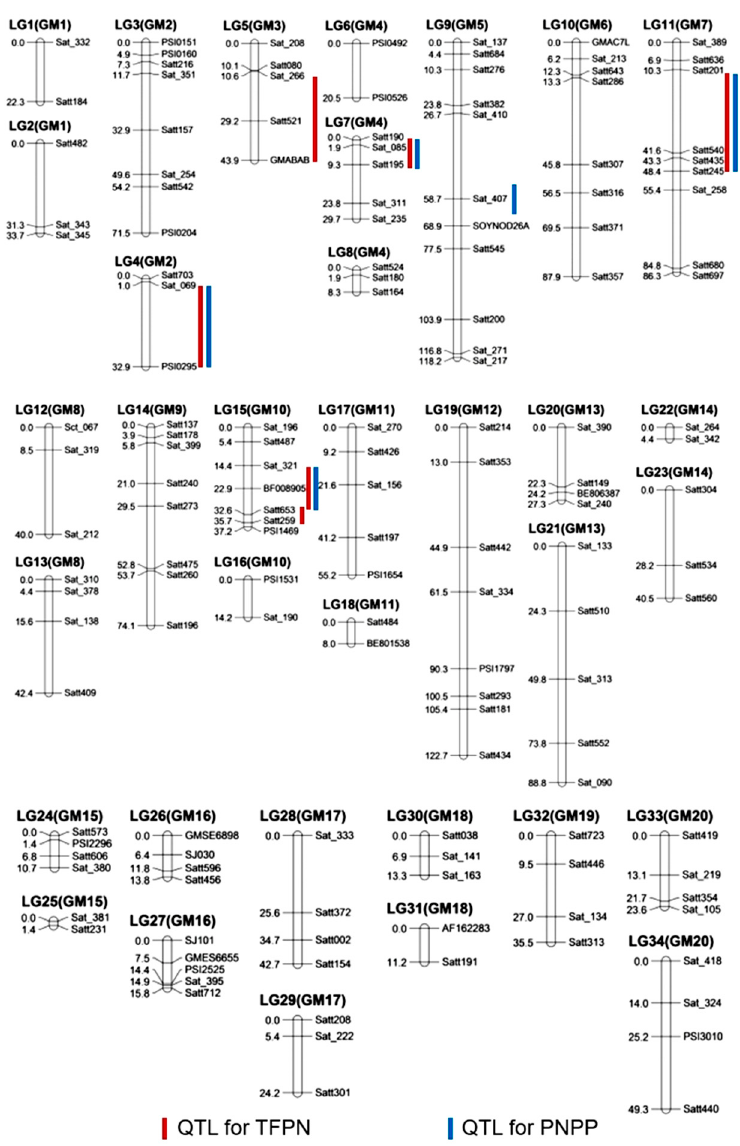
Figure 2. The genetic map of the RIL population and the QTL for TFPN and PNPP.